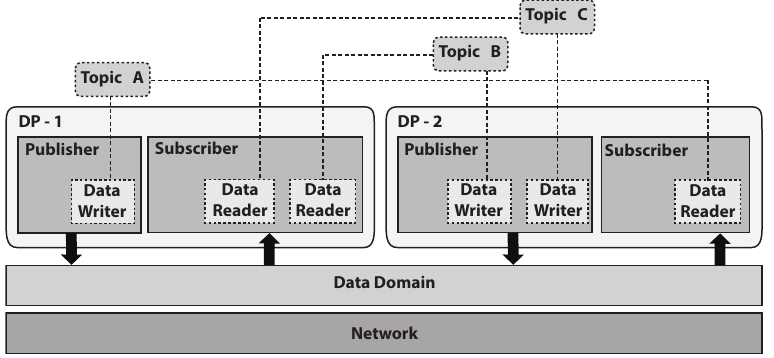
Figure 1. Data-Centric Publish–Subscribe (DCPS)